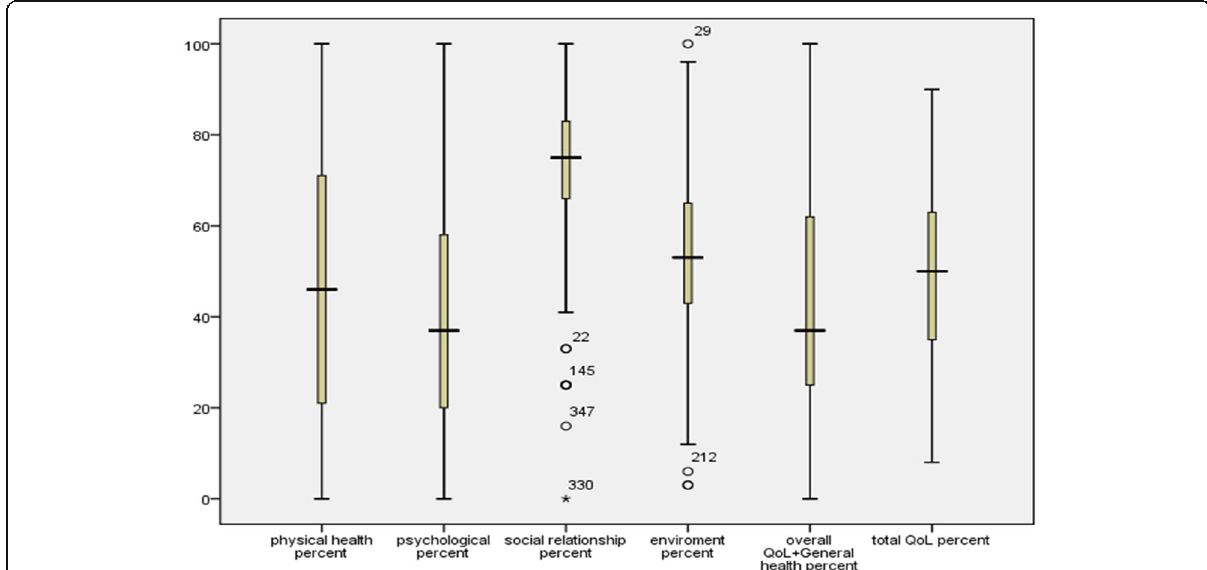
Fig. 1 Box plot indicating median, quartiles and extreme values for domains of